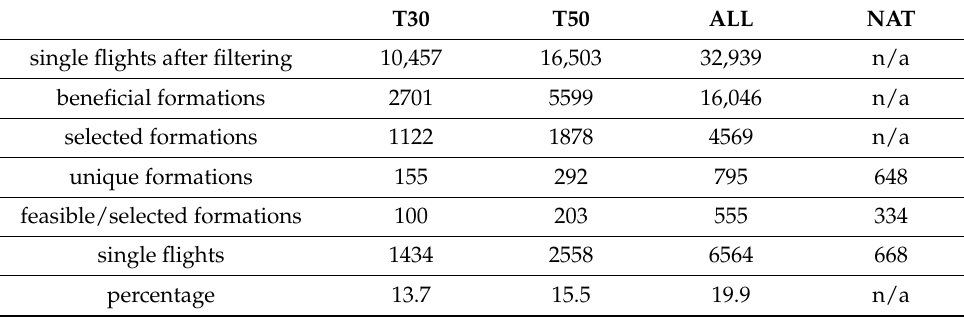
Table 1. General statistics for the different scenarios assessed in this